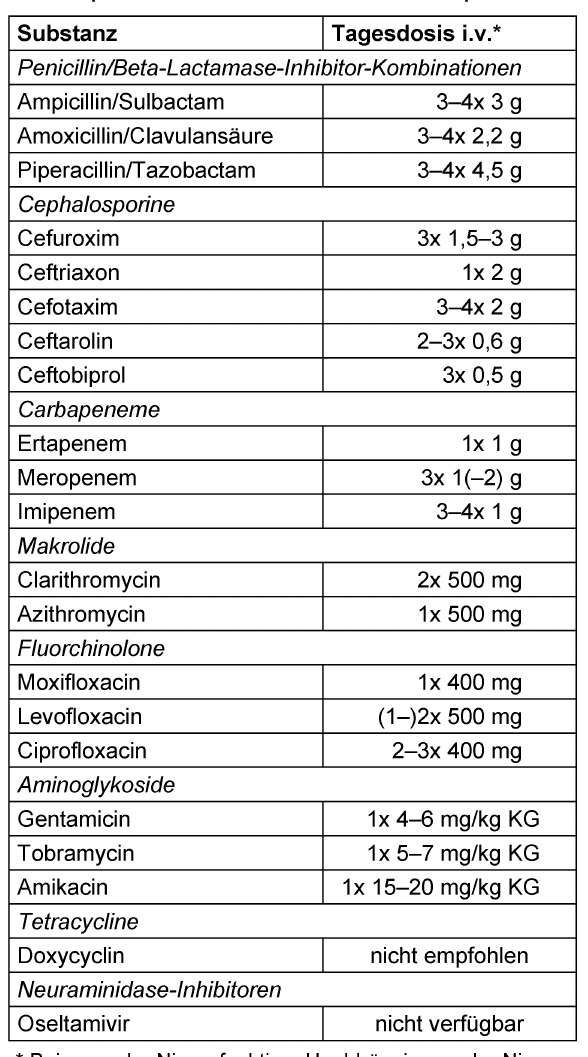
Tabelle 7: Dosierungsempfehlungen für die